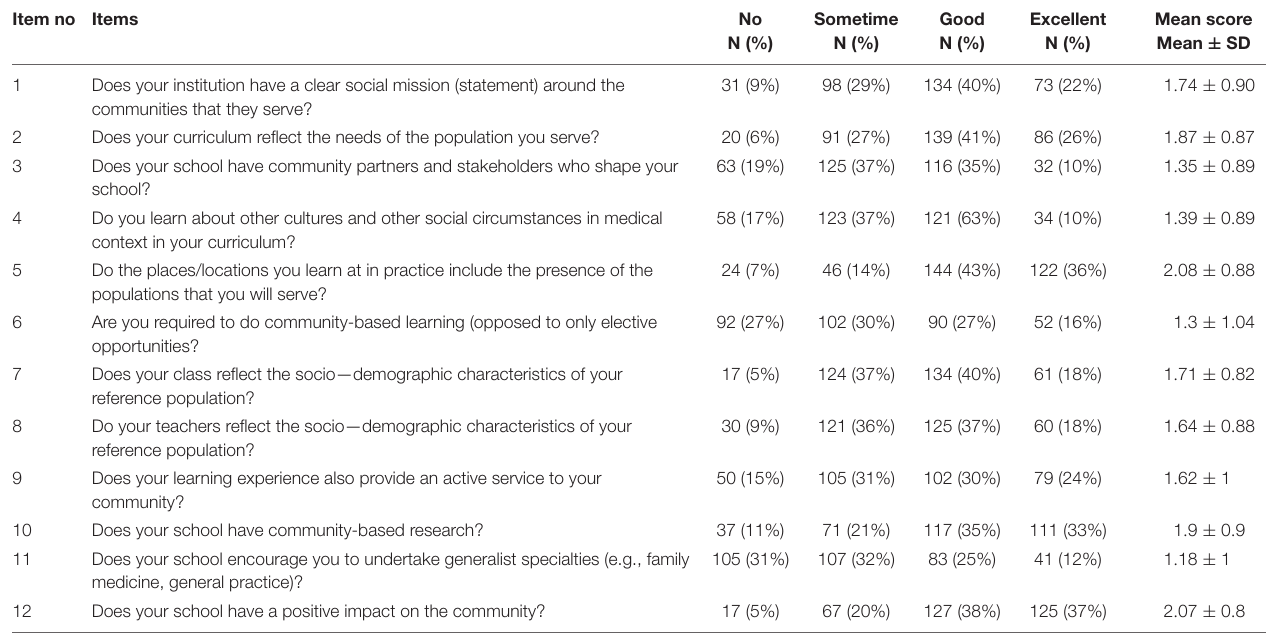
TABLE 2 | Descriptive summary of the items determining social accountability ( n = 336).